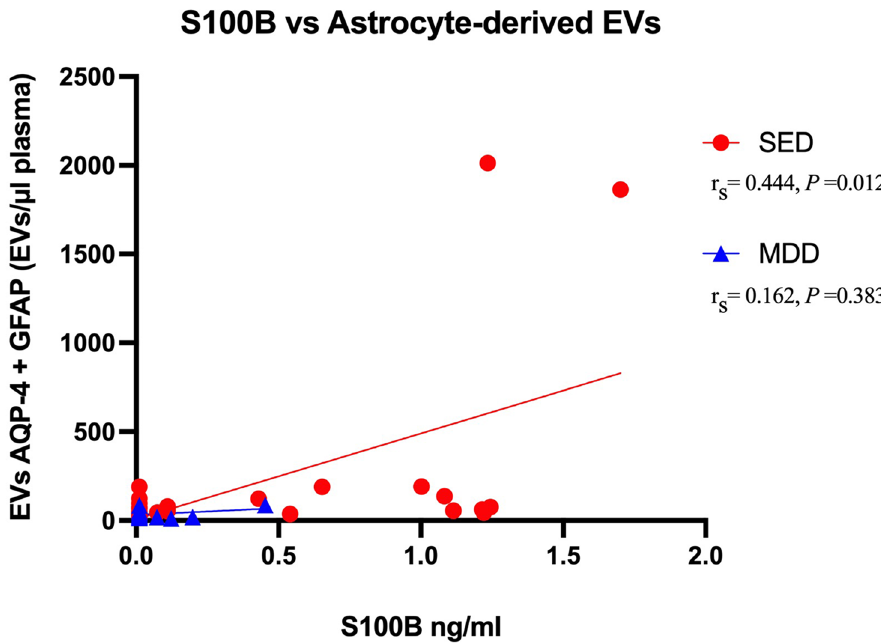
Figure 3. Rank correlation between plasma levels of S100B and astrocyte-derived extracellular vesicles (EVs) in patients with stress-induced exhaustion disorder and patients with major depressive disorder. Red filled circle = patients with stress-induced exhaustion disorder, blue filled triangle = patients with major depressive disorder. Healthy controls are not shown because levels of S100B were not measurable in this